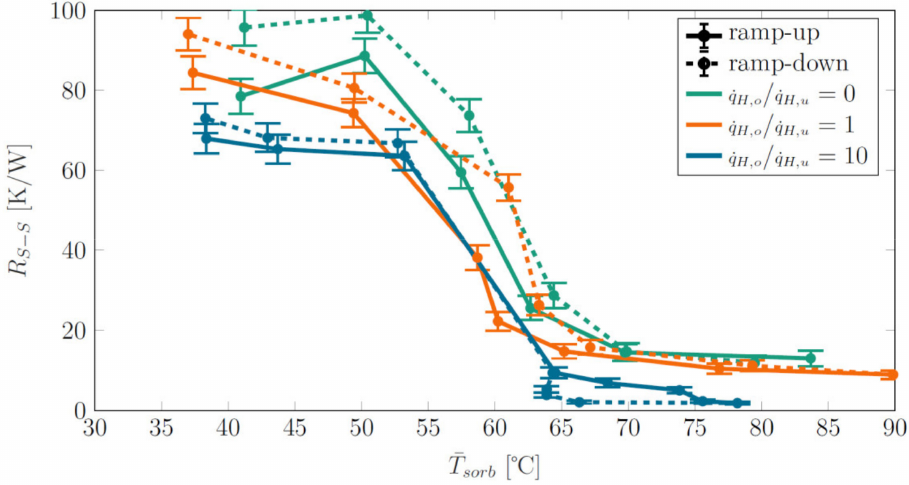
Figure 10. “Hysteresis plot”: Thermal resistance R S − S vs. average sorbent temperature T sorb for both heat power ramp-up (full lines) and ramp-down (dashed lines). Data are given for selected heat . . q q power density rations / as obtained from Siphon-2 with a sorbent weight of 4 H , o H , u